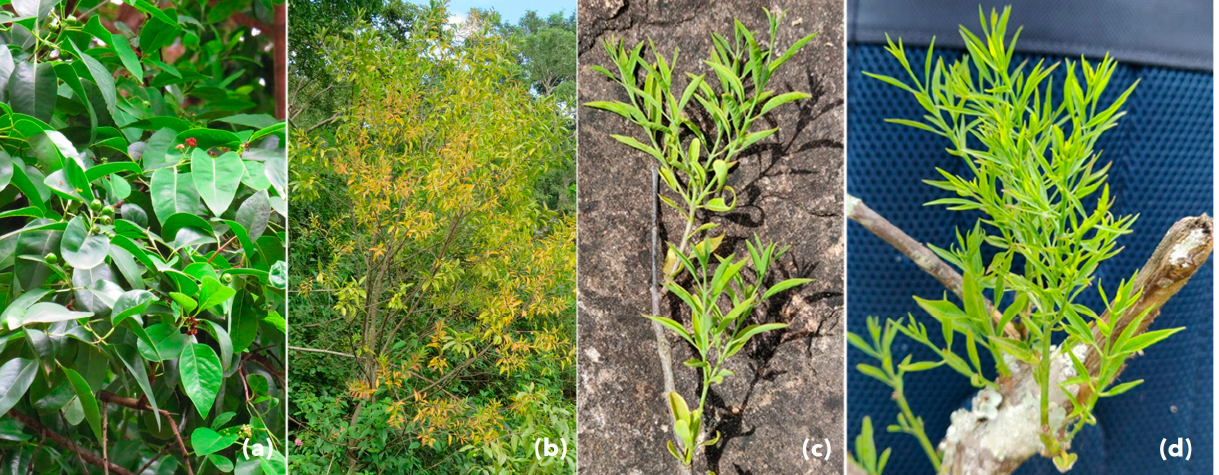
Figure 3. Healthy sandalwood tree bearing levees, inflorescence, and fruits ( a ) and phytoplasma infected sandalwood ( Santalum album L.) tree showing typical symptoms of shoot spike, little leaf, and discoloration of leaves ( b ); sandalwood branches and twigs showing typical symptoms of SSD ( c , d